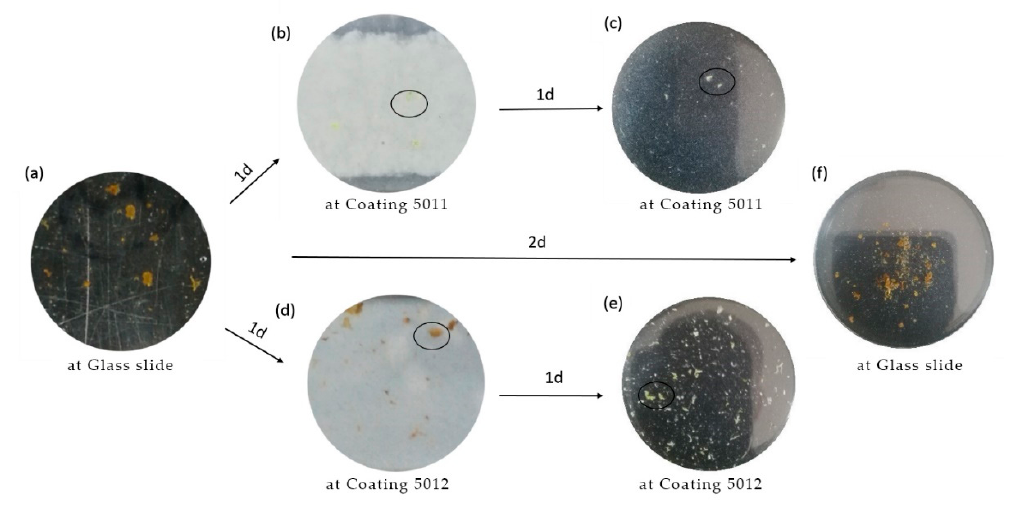
Figure 11. Changes in Navicula Tenera solution during test. ( a ) at glass slide before test; ( b ) at coating 5011 for 1 day; ( c ) at coating 5011 for 2 day; ( d ) at coating 5012 for 1 day; ( e ) at coating 5012 for 2 day; ( f ) at glass slide after test.